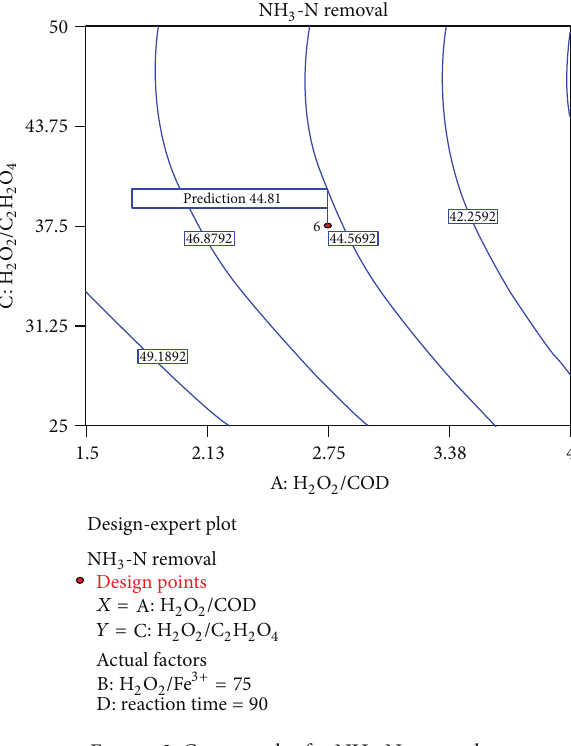
Figure 3: Contour plot for NH 3 -N removal.